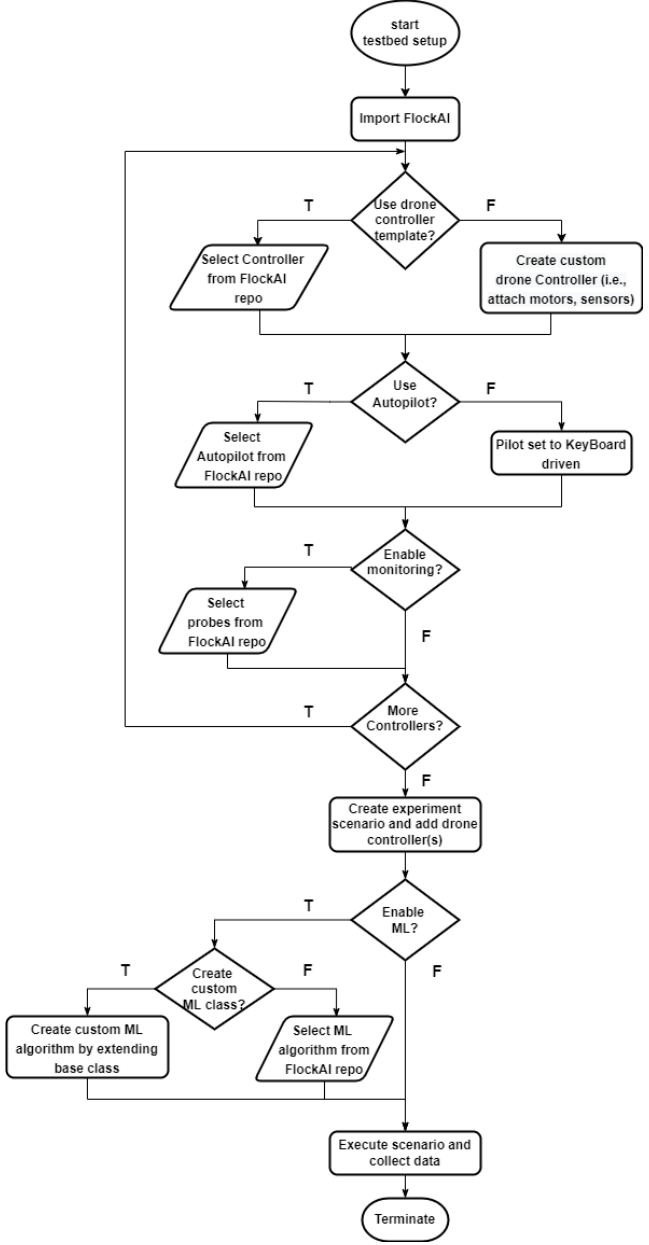
Figure 3. FlockAI experiment testbed setup